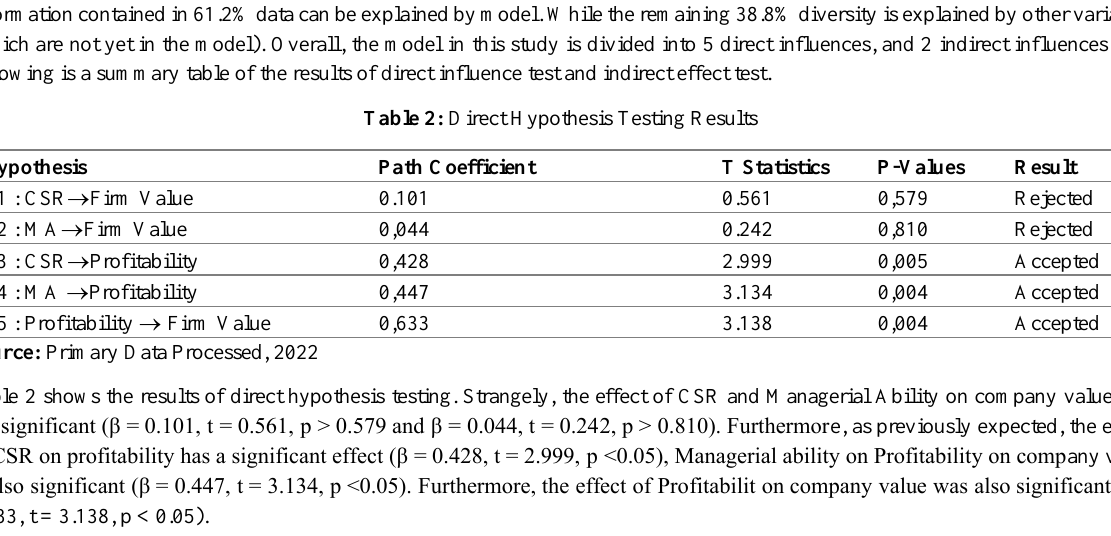
Table 3: Indirect hypothesis test